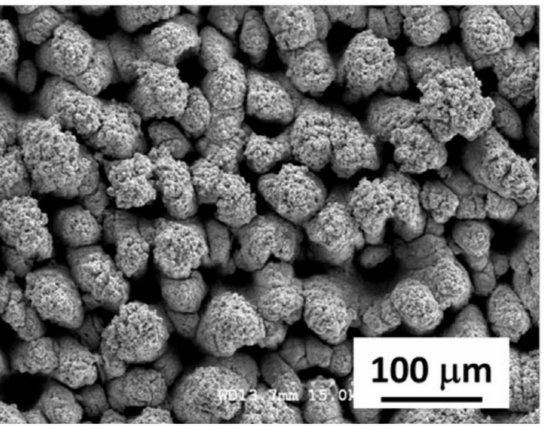
Figure 5. An SEM image of cauliflower-like ablation texture. Reprinted with permission from [93], Wiley,